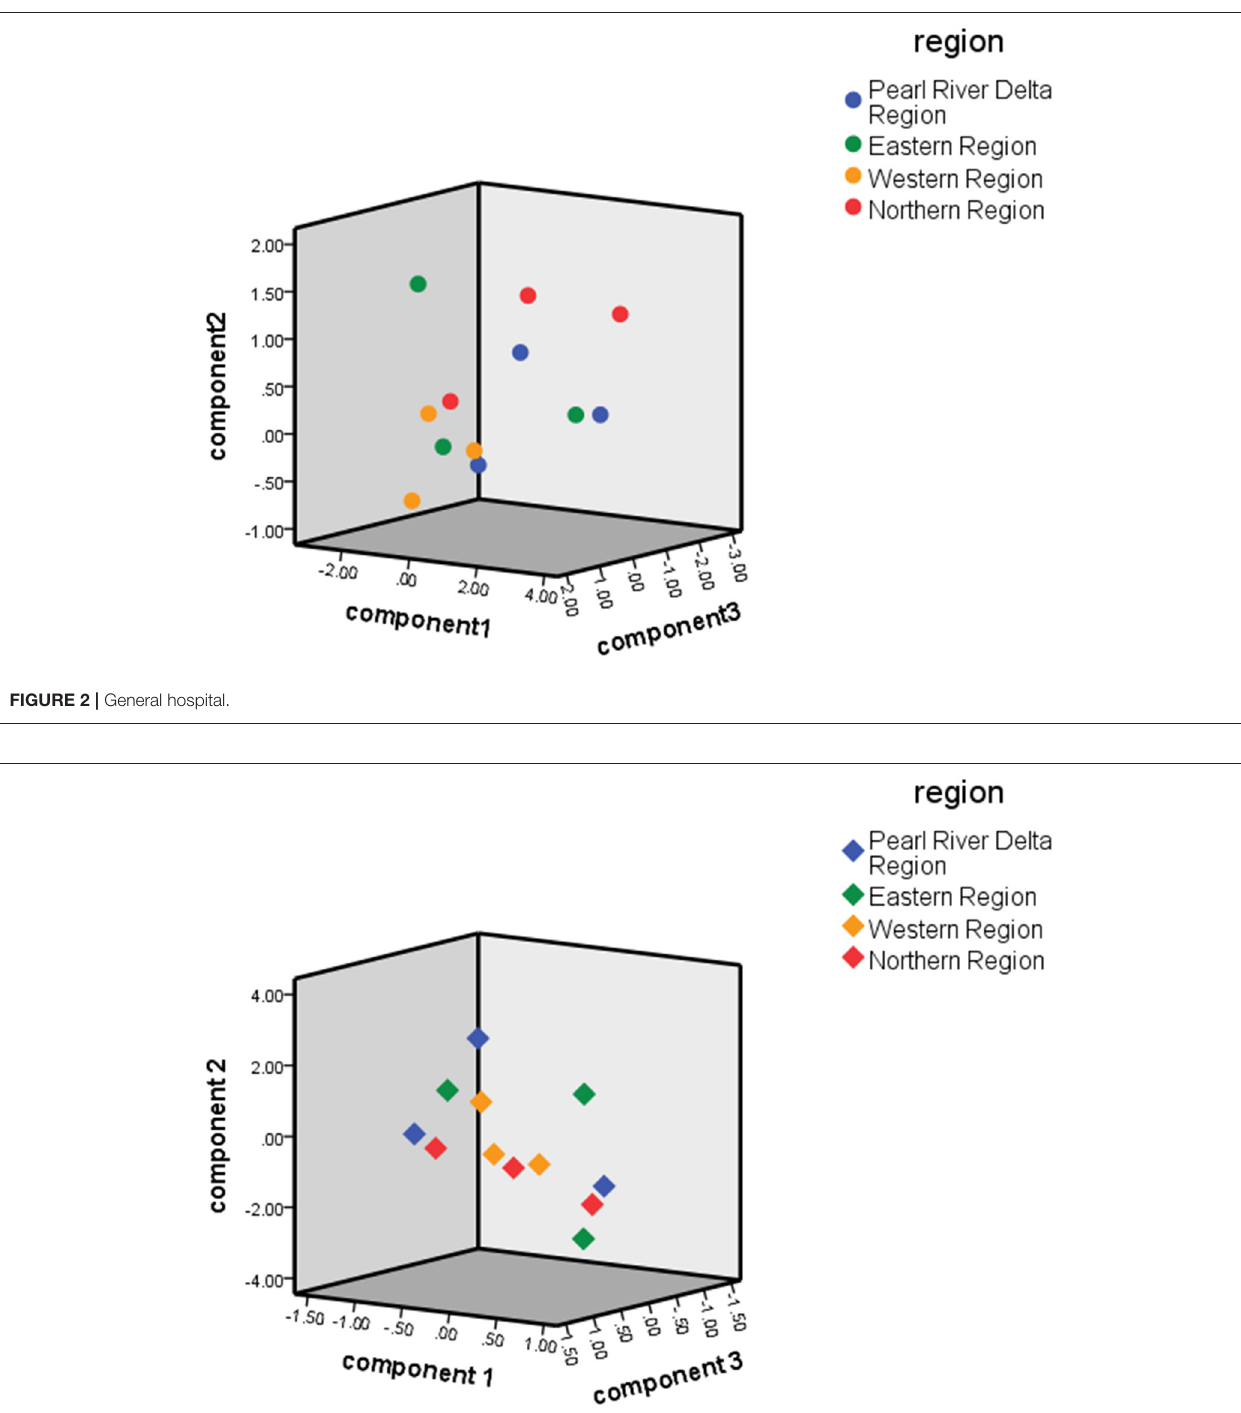
each patient receives (33). The government needs to consider the status quo of public hospitals when formulating price